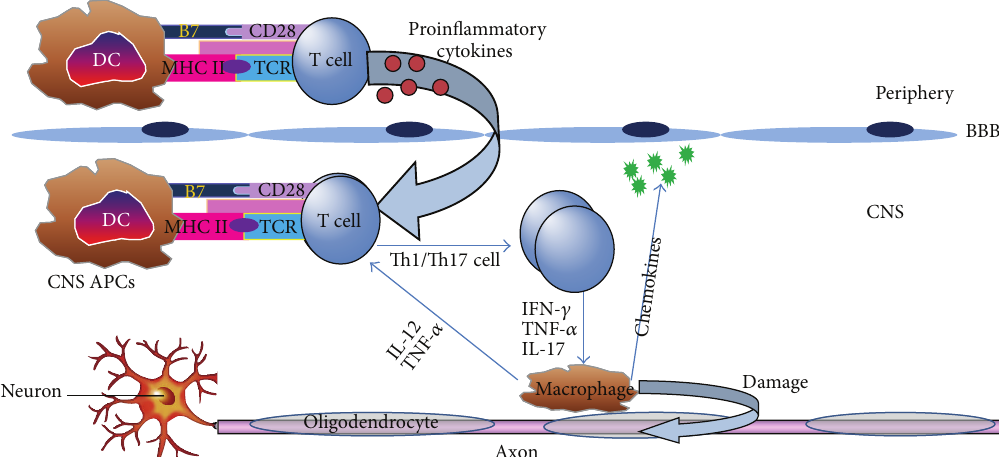
Figure 2: Role of dendritic cells (DCs) in the pathogenesis of multiple sclerosis (MS)/experimental autoimmune encephalomyelitis (EAE). As professional antigen-presenting cells (APCs), DCs in the periphery could activate the T cells upon pathological stimulation resulting in secreting proinflammatory cytokines, aiding their entry through the endothelial blood-brain barrier (BBB) to the CNS; then these myelin- reactive T cells are reactivated upon encounter with resident APCs including DCs which present myelin-derived epitopes. Subsequently, these perivascular T cells will secrete proinflammatory cytokines which result in recruitment of other inflammatory cells. Consequently, this will lead to demyelination of axons accounting for the sensory and motor deficits of